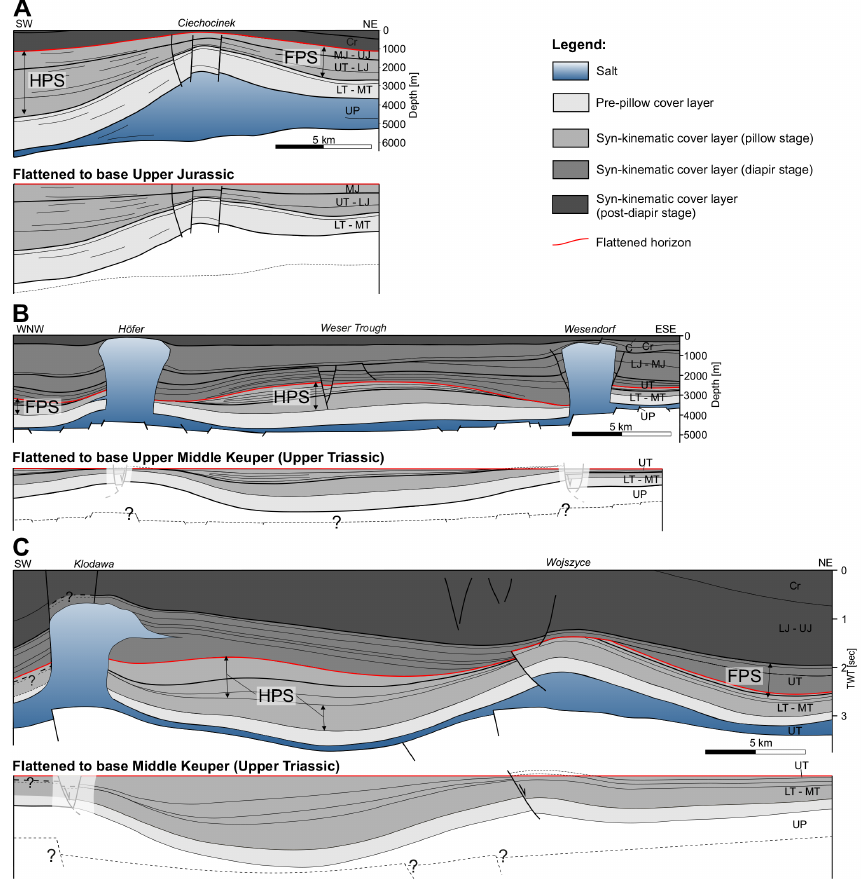
Figure 14. Interpreted seismic profiles of salt structures including reconstruction of the hanging wall peripheral sink (HPS) and the footwall peripheral sink (FPS). The sub-salt basement has not been restored, but its assumed geometry is schematically denoted. (a) The cross-section of the Mid-Polish Basin (modified after Dadlez, 2003) shows a typical salt pillow that was probably initiated by differentially subsided basement. In cross-sections b–c , the main depocentres overlie the downthrown basement part and salt structures are located above basement highs. (b) The Weser Trough (Central North German Basin) experienced several extensional phases during the Mesozoic, which led to the formation of salt pillows during Early Triassic and to diapiric piercing during the Late Triassic (modified from Baldschuhn et al., 2001). (c) The salt structures Klodawa and Wojszyce in the Mid-Polish Trough were initiated during the Middle to Late Triassic above a half graben (modified from Krzywiec, 2004b). Late Cretaceous inversion caused strong uplift of the sub-salt basement. UP – Upper Permian; LT – Lower Triassic; MT – Middle Triassic; UT – Upper Triassic, LJ – Lower Jurassic; MJ – Middle Jurassic; UJ – Upper Jurassic, Cr – Cretaceous; C – Cenozoic. For locations of the profiles see